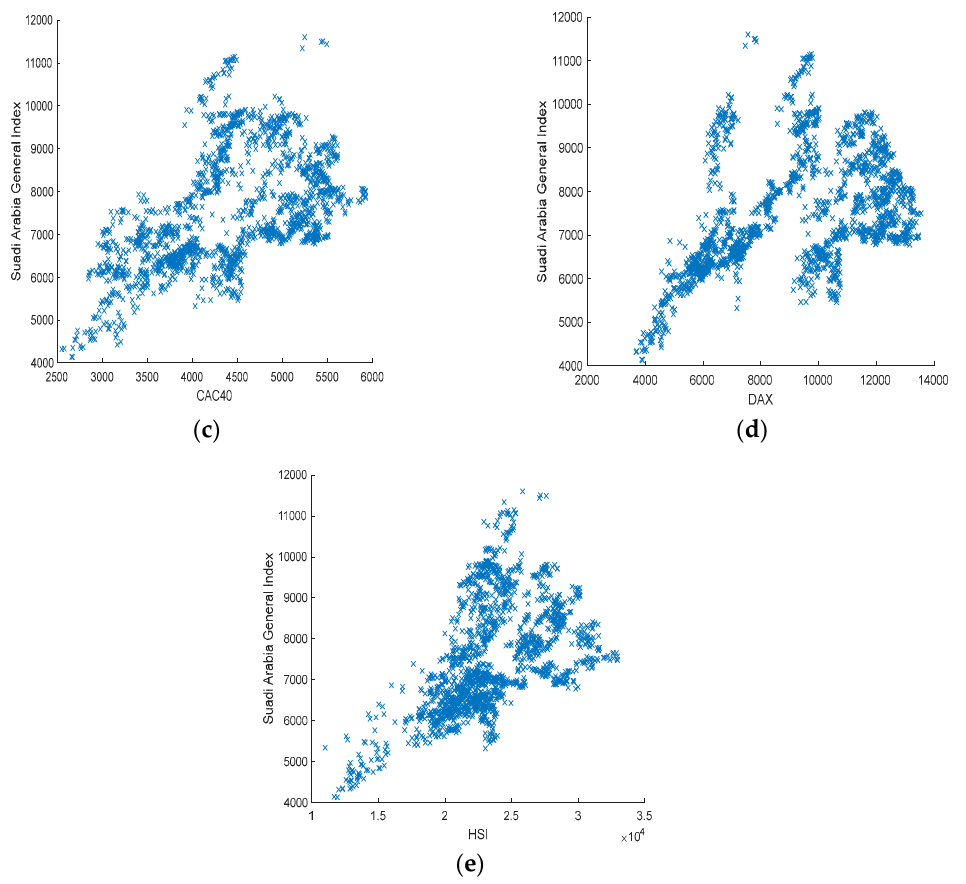
Figure 4. The relationship between the Tadawul index (TASI) and ( a ) S&P500, ( b ) NIKKEI, ( c ) CAC40, and the ( d ) DAX and ( e ) HSI stock market indices.